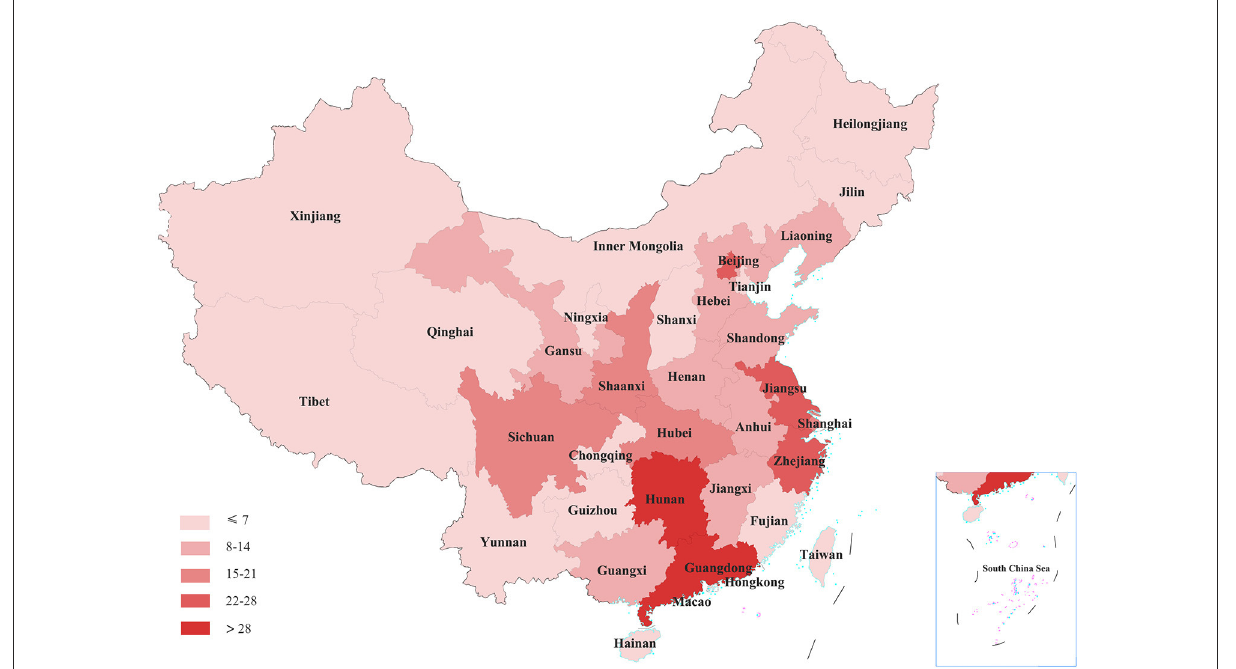
FIGURE3 The distribution of medical workplace violence cases in different provinces of